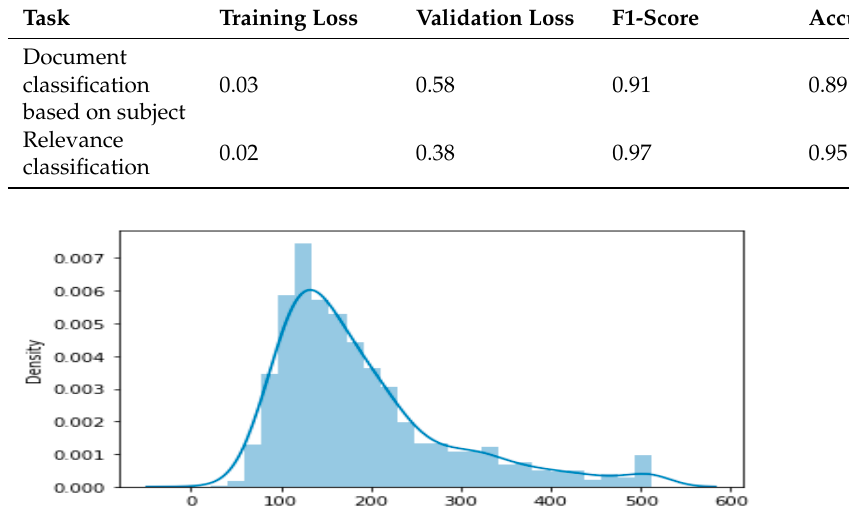
Figure 6. Number of tokens in document classification training and testing datasets.